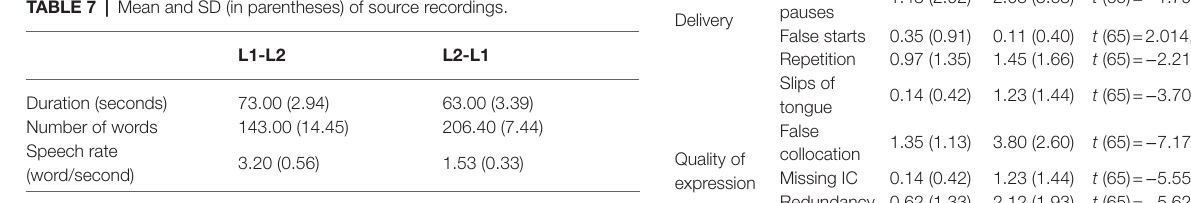
TABLE 7 | Mean and SD (in parentheses) of source recordings.